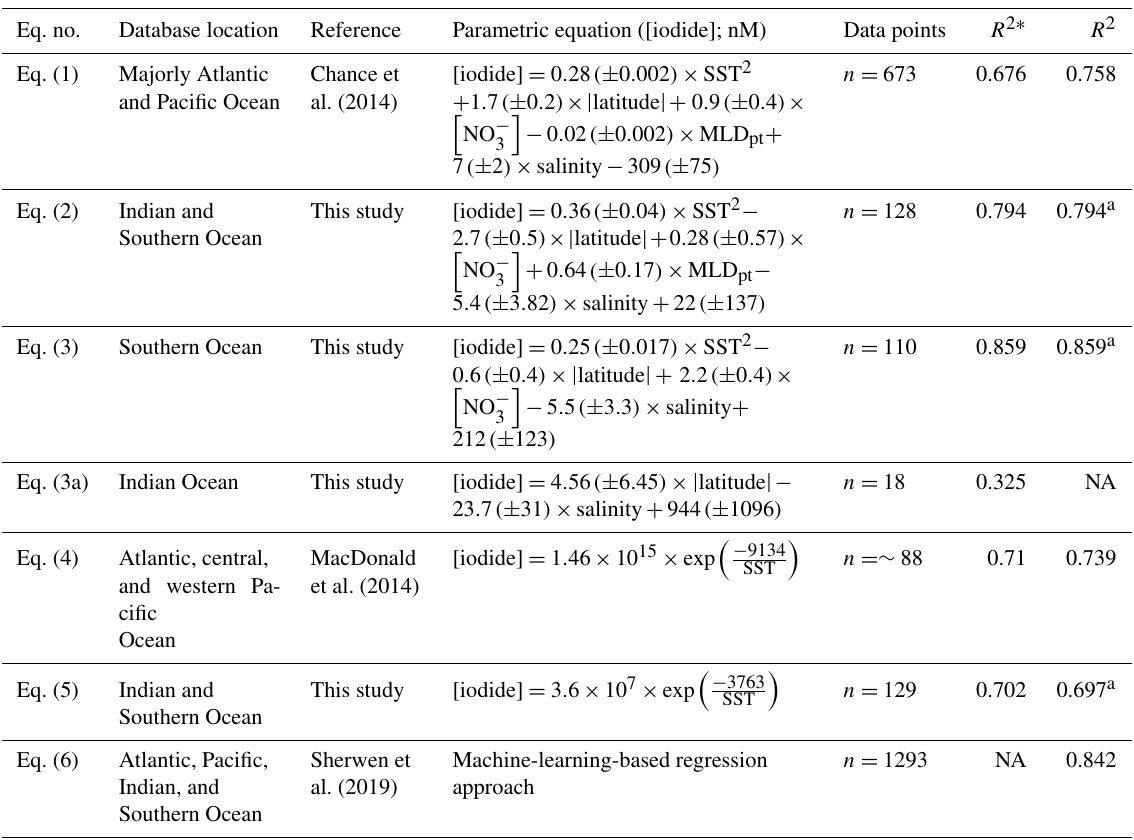
Table 2. List of existing global (italicised reference column) and new region-specific (regular font in reference column) parameterisations for sea surface iodide concentration indicating data location and number of data points used to formulate each equation. Here [iodide] represents the sea surface iodide concentration (nM), and sea surface temperature is SST (in degrees Celsius for Eqs. (1) to (3) and in Kelvin for Eqs. 4 to (cid:16)(cid:104) (cid:105)(cid:17) 5). The nitrate concentration NO − is given in micromoles (µM), the mixed layer depth is MLD pt in metres, the subscript “pt” indicates 3 potential temperature implying a temperature change of 0.5 ◦ C from the ocean surface (Monterey and Levitus, 1997), and salinity is in practical salinity units (PSU). Further details on individual parameters and the choice of Eq. (1) over others proposed in Chance et al. (2014) are discussed in the Supplement. R 2 ∗ represents the initial coefficient of determination (COD) while deriving each parameterisation, and R 2 represents the COD from correlation analysis of the calculated iodide with observations in this study (ISOE-9, SK-333, BoBBLE). Eq.